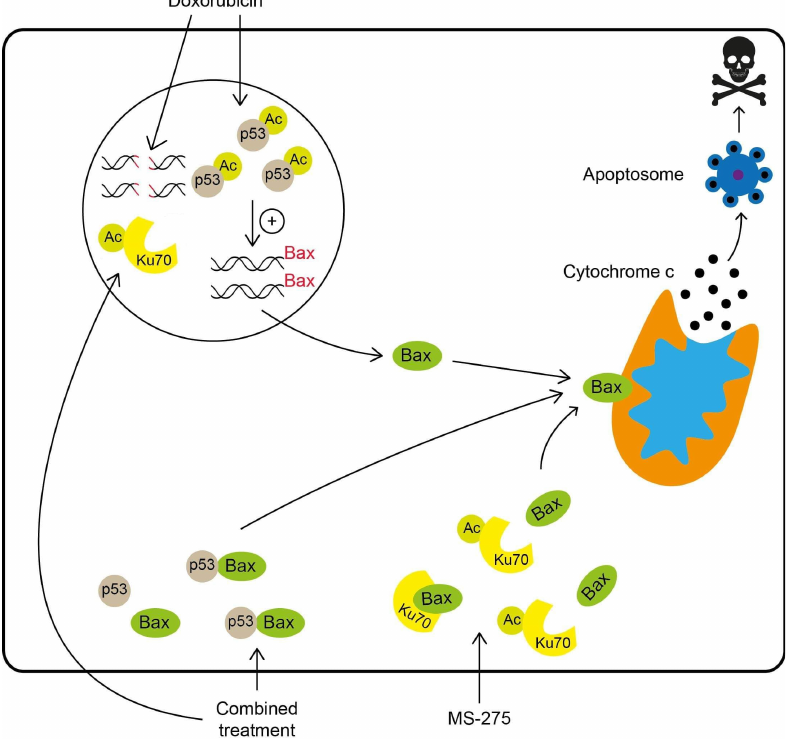
Figure 4. Comparison between treatments with MS-275, Doxorubicin, and their combination, lead- ing to the apoptosis of the MB cells. Monotherapy with Doxorubicin causes the acetylation and nuclear accumulation of p53, which induces Bax expression. Bax protein then oligomerizes to the mitochondrial outer membrane, causing cytochrome c release, which induces apoptosis. Acetylation of the Ku70 protein with MS-275 releases Bax and leads to apoptosis. Combined treatment with Doxorubicin and MS-275 shows a synergistic apoptotic effect. It promotes the binding of p53 to Bax, leading to Bax activation and the loss of mitochondrial membrane potential, as well as greater DNA damage. Ku70, acetylated by MS-275, has reduced DNA repair activity. Thus, DNA strand breaks caused by the Doxorubicin are left